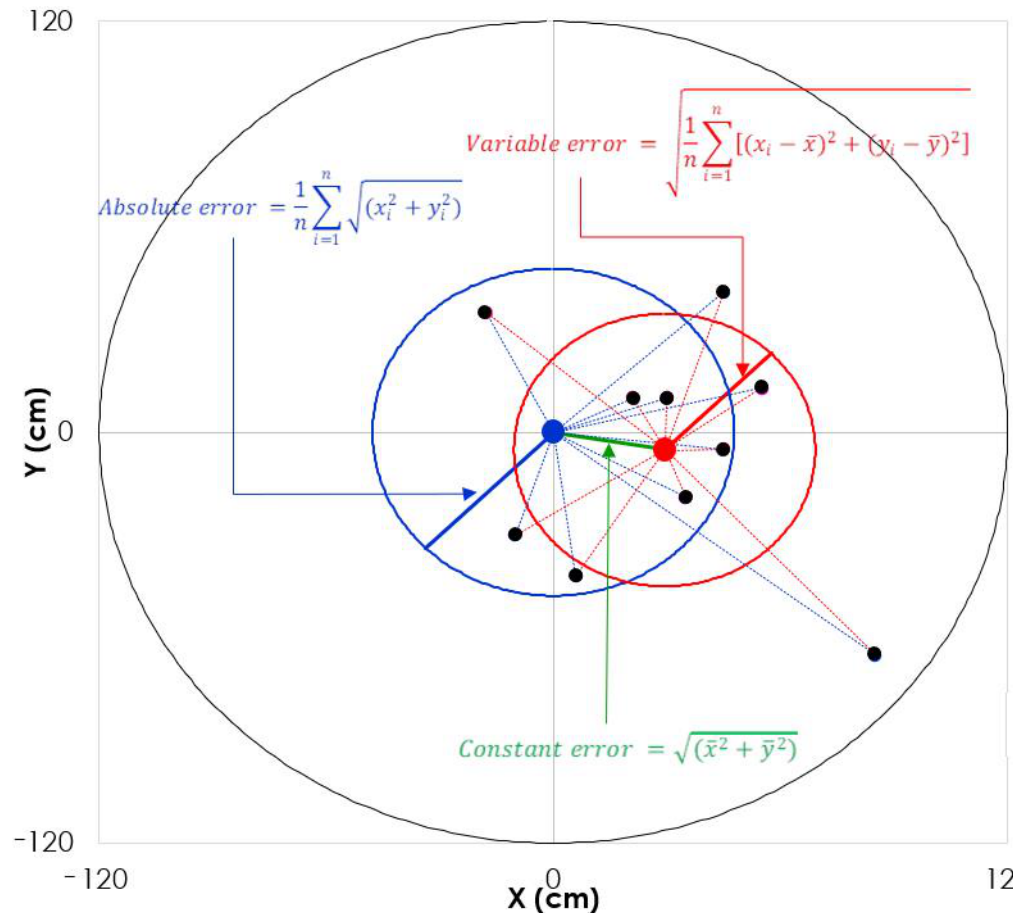
Figure 2. Schematic representation of the ten bullet impact points with the target and the three accuracy errors. The large black circle represents the target (1.2 m radius); The blue point represents the center of the target; The ten black dots represent the points of impact of the ball with the target; Blue dashed lines represent absolute errors; The radius of the blue circle represents the mean absolute error of the 10 shots; The red point represents the barycenter of the 10 black points; Red dashed lines represent relative errors; The radius of the red circle represents the average relative error of the 10 shots; The green line represents the constant error.